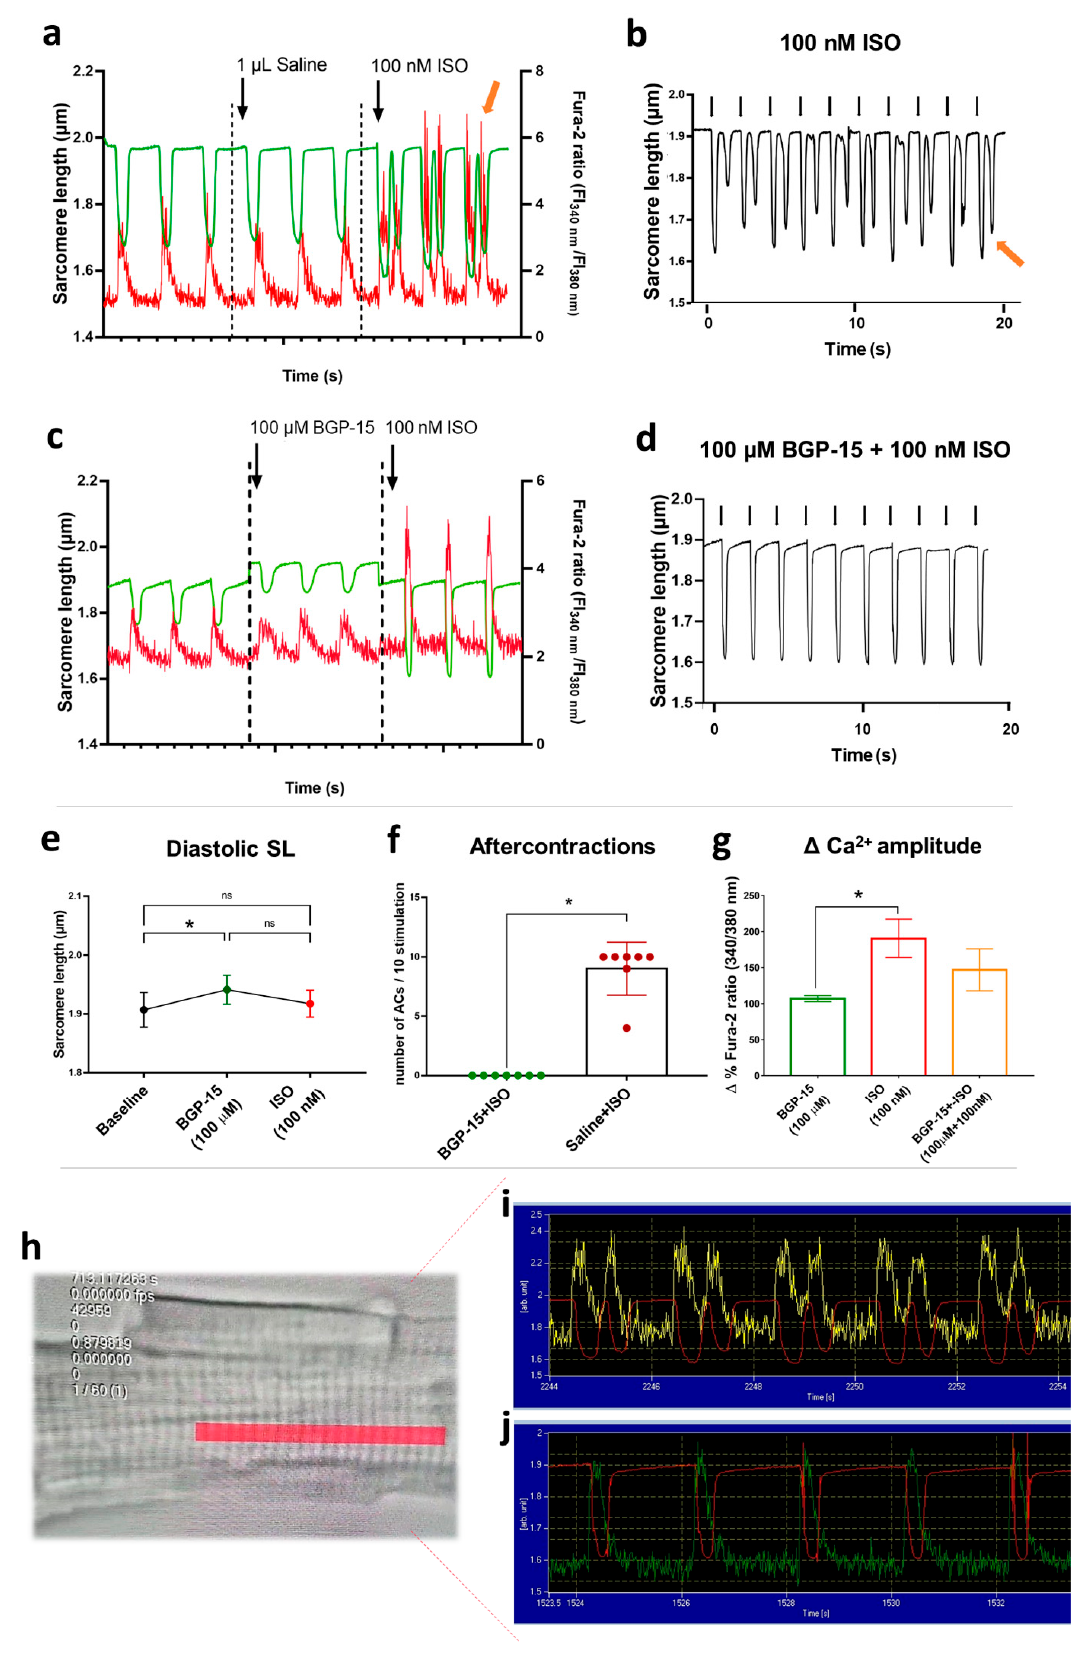
Figure 5. Effects of BGP-15 and ISO treatment in isolated cardiomyocytes. ( a ) After vehicle